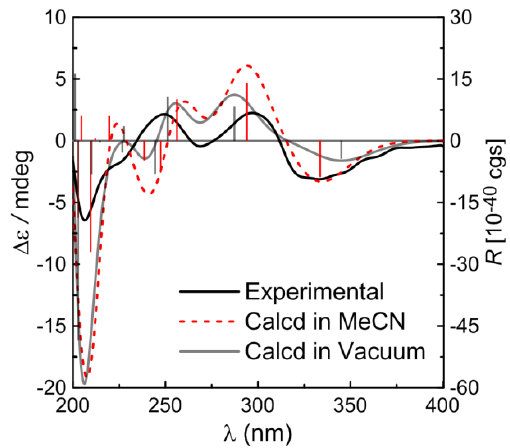
Figure 4. Calculated CD spectra of compound 2 in MeCN solution (red) and in vacuum (gray) and comparison between the calculated and experimental CD (black) spectra. Vertical bars represent rotational strengths R . σ = 0.24